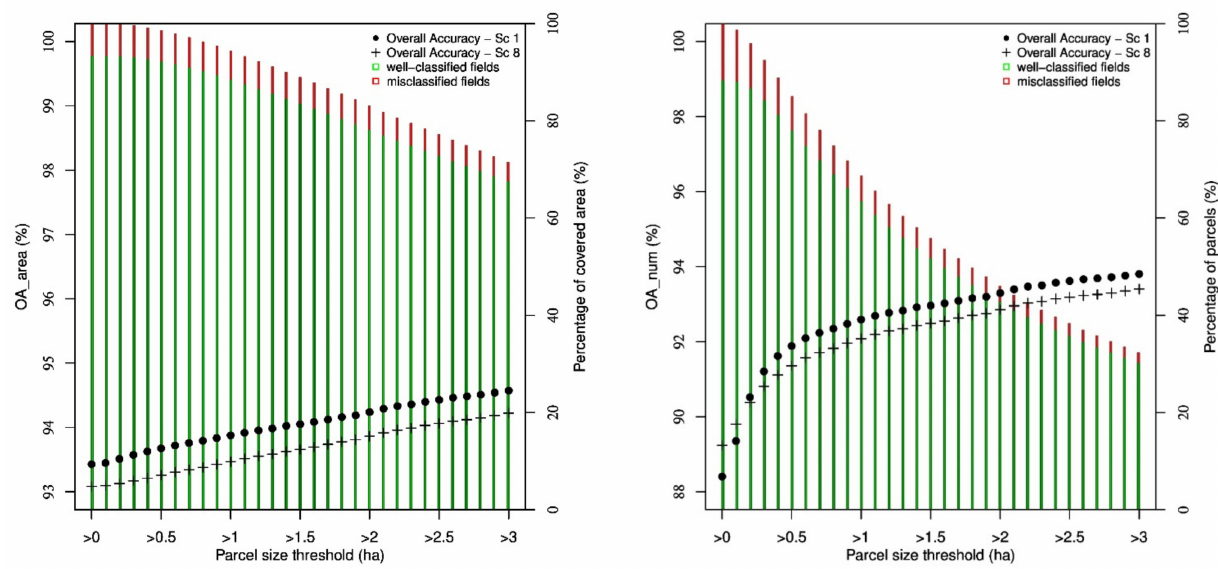
Figure 4. Evolution of the overall accuracy when considering a threshold on the parcel area. ( Left ): OA in terms of the area. ( Right ): OA in terms of the number of